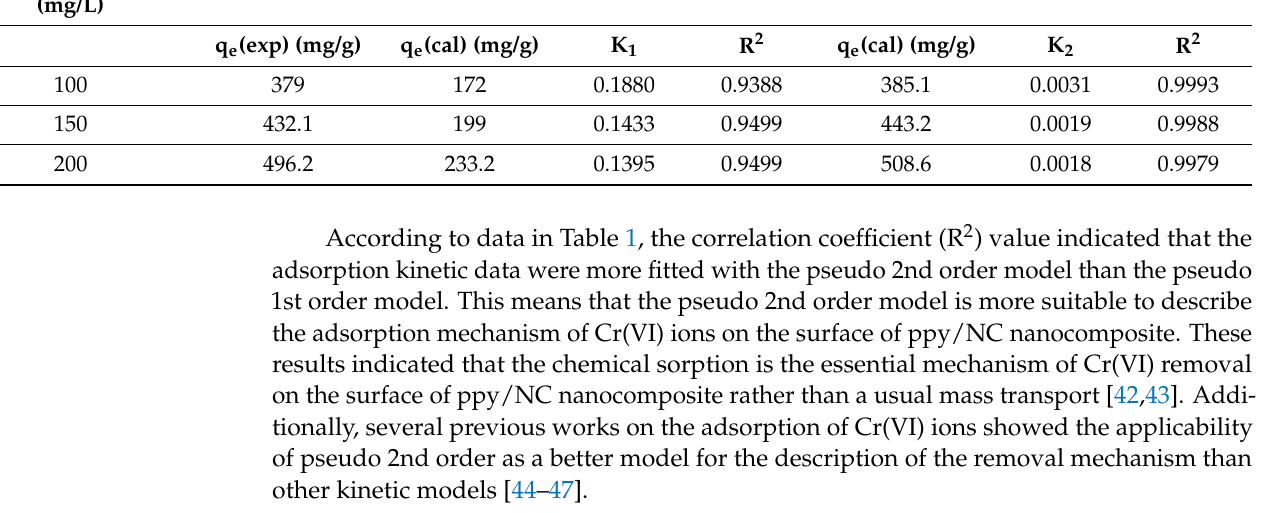
Table 1. The parameters of pseudo 1st order and pseudo 2nd order models for the removal of Cr(VI) on the surface of ppy/NC nanocomposite. Cr(VI)